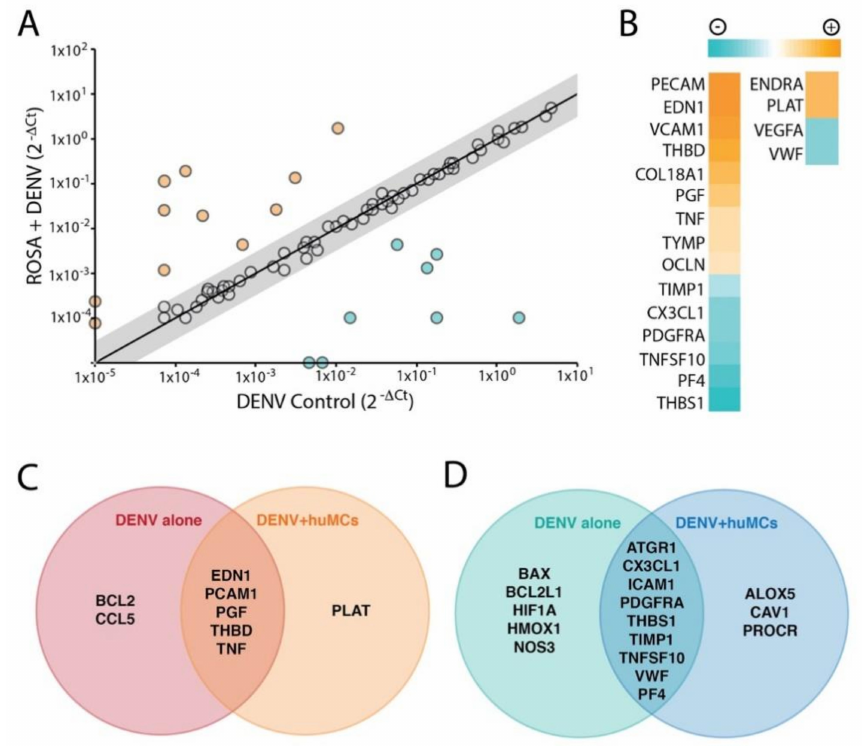
Figure 4. DENV-elicited MC products induce endothelial activation. ( A ) The graph shows the expression levels of unique genes over baseline expression in huMECs, 24 h after treatment with DENV alone or huMC + DENV. ( B ) A heat map of up- and down-regulated genes after treatment with supernatants from huMC + DENV, which were compared to DENV alone. ( C , D ) The up- and down-regulated genes are presented as Venn diagrams, representing the genes that were either similarly ( C ) upregulated or ( D ) down-regulated by DENV alone exposure and huMC products elicited by DENV (huMC + DENV) compared to control huMECs. Genes without significantly di ff erent levels of expression compared to control between DENV and huMC + DENV are located in the overlapping regions in C–D. Unique regions in the Venn diagrams that do not overlap designate genes that were uniquely expressed by only one treatment condition, whereas expression was not detected in the other treatment